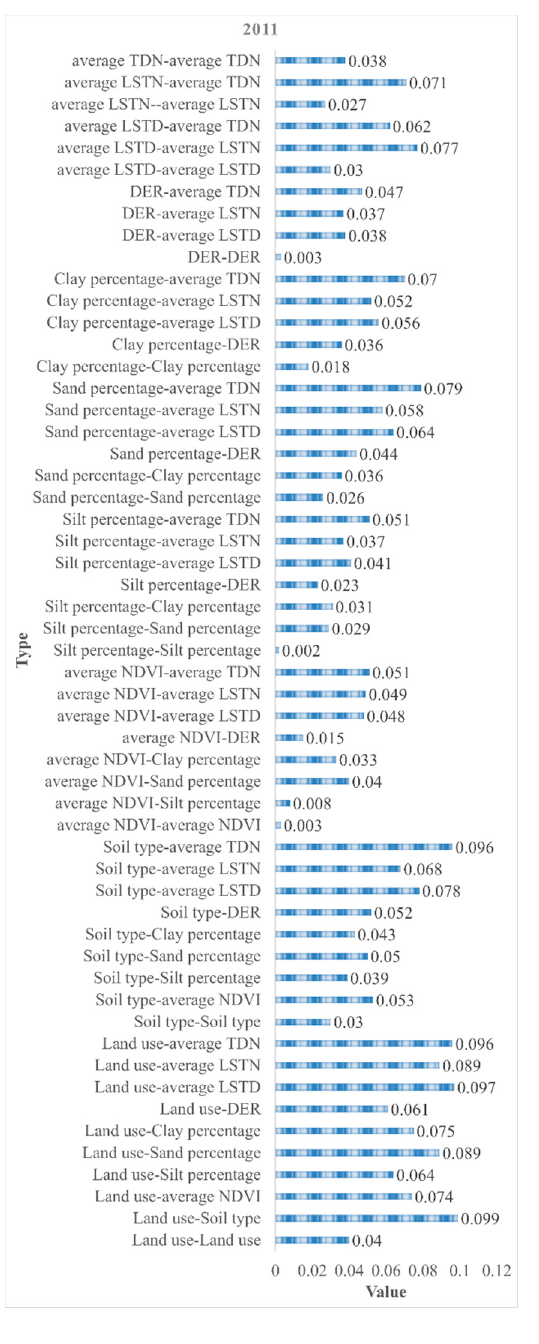
Figure 5. Results of analysis of the interaction detectors. Average NDVI, average normalized different vegetation index; DER, distance from the endemic villages to the river; average LSTD, average land surface temperature at daytime; average LSTN, average land surface temperature at night; average TDN, average day and night temperatures.